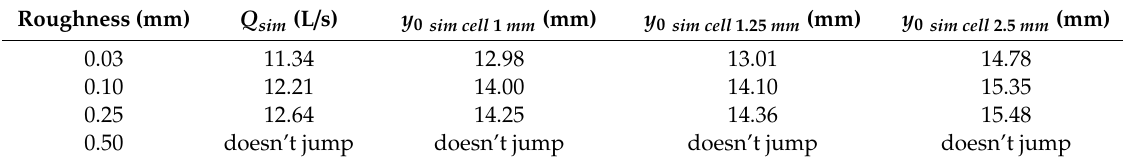
Table 3. Calibration results (roughness variation) and mesh-sensitivity analysis (cell side variation).